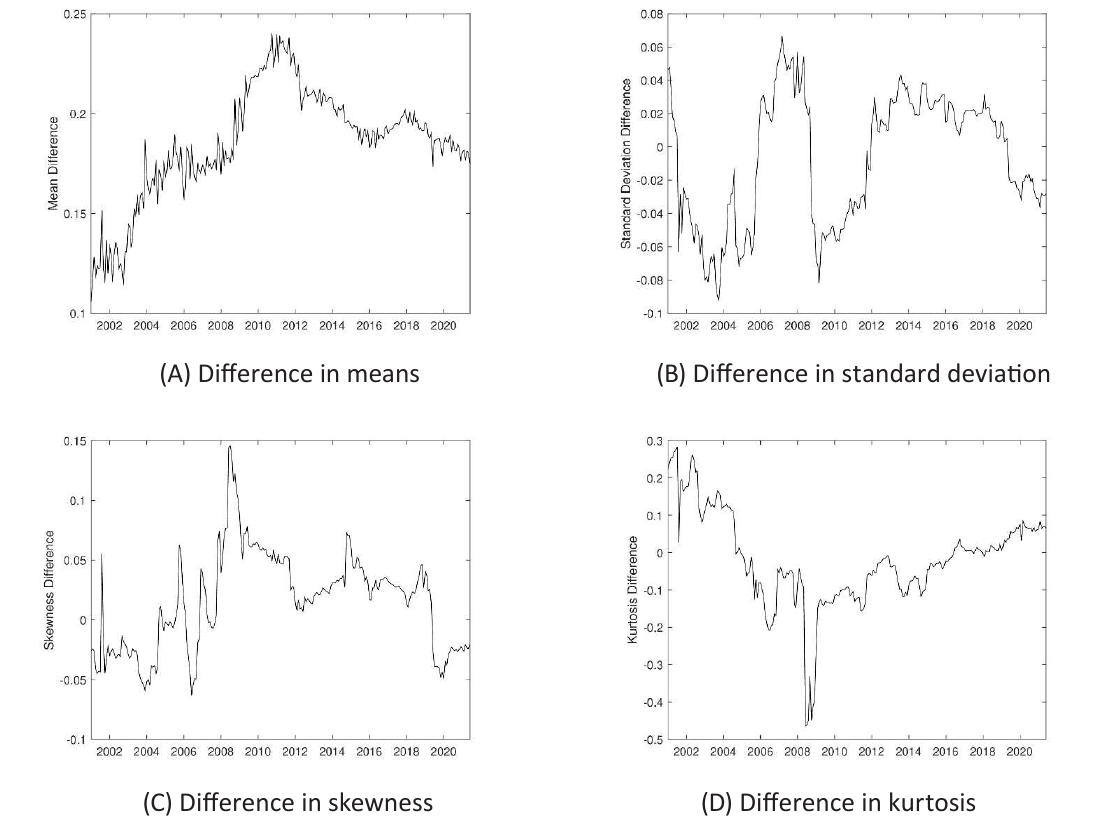
(C) Difference in skewness (D) Difference in Figure 8. Difference in 3-year moments rolled through time for DIA and DJIA differences. Panel D plots the kurtosis differences.